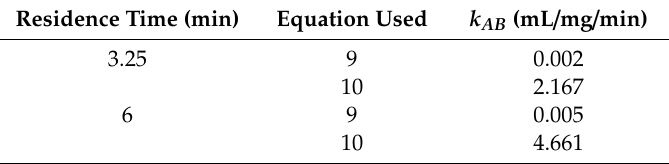
Table 3. Kinetic constants calculated from the y-intercept.